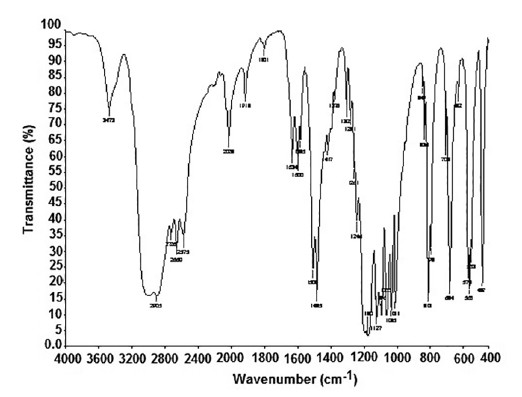
Figure 5: FTIR spectrum of 4BPTS crystal.